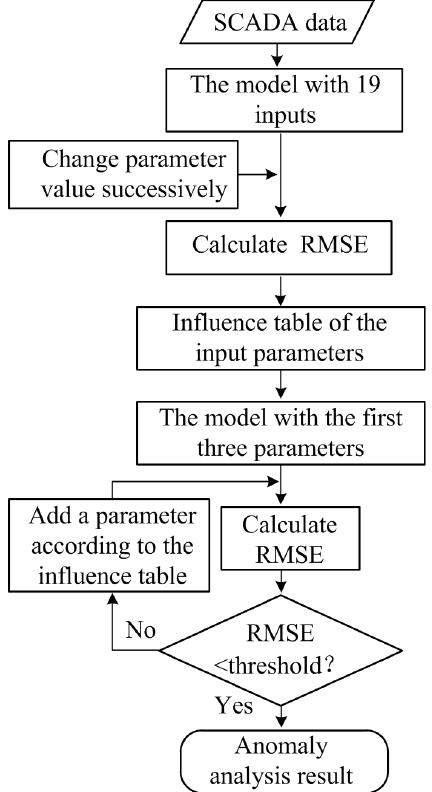
Figure 8. Procedures to establish the model for anomaly detection.